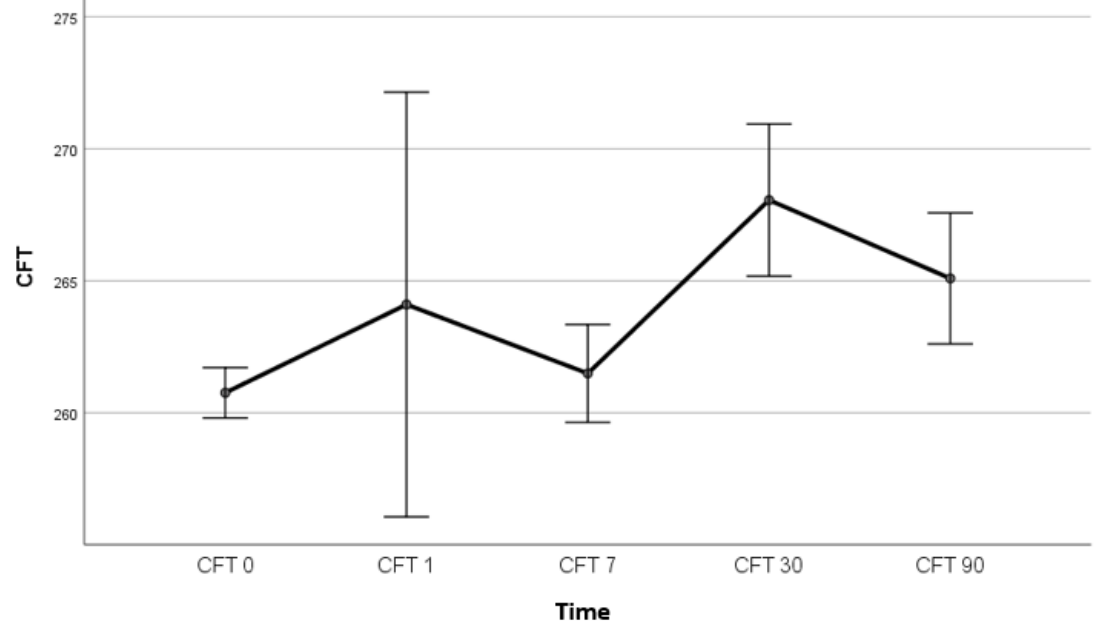
Figure 2. CFT (µm) was significantly lower in experimental Group 2 (topical dexamethasone) than in the placebo group 90 days after the surgery ( F (2.86) = 4.46, p < 0.014). Differences in CFT between experimental Group 1 (topical bromfenac) and the placebo group, as well as between the two ex- perimental groups, were not statistically significant; Bromfenac group n = 30; Dexamethasone group n = 30; Placebo group n = 30; CFT, central foveal subfield thickness.